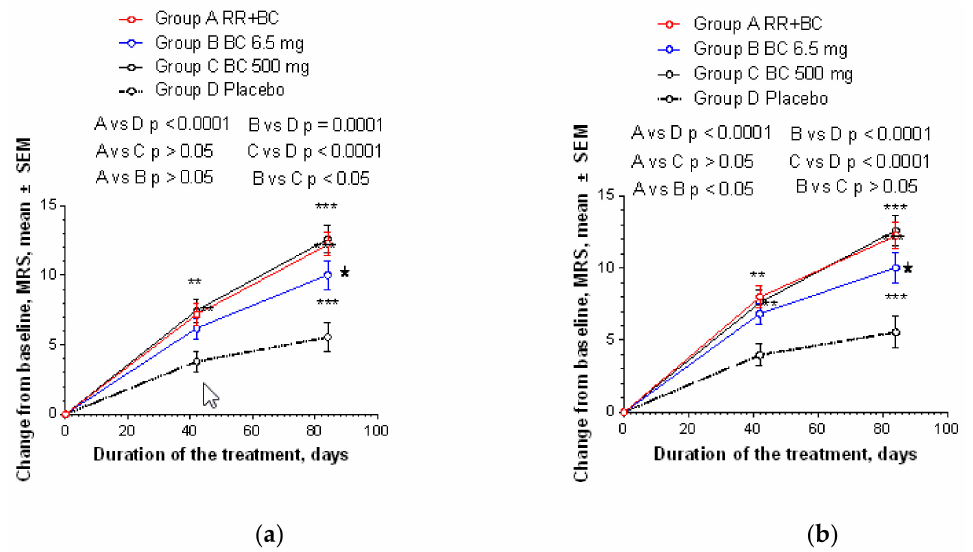
Figure A2. The change from baseline of MRS (mean ± SD) over time: ( a ) -ITT analysis, ( b) -PP analysis. Significance of di ff erence between groups at various time points, calculated by Bonferroni post-test, is expressed by symbols ** p < 0.01, *** p < 0.001; ns: not significant (A, B, C vs. placebo) and * p < 0.05 (B and C vs.